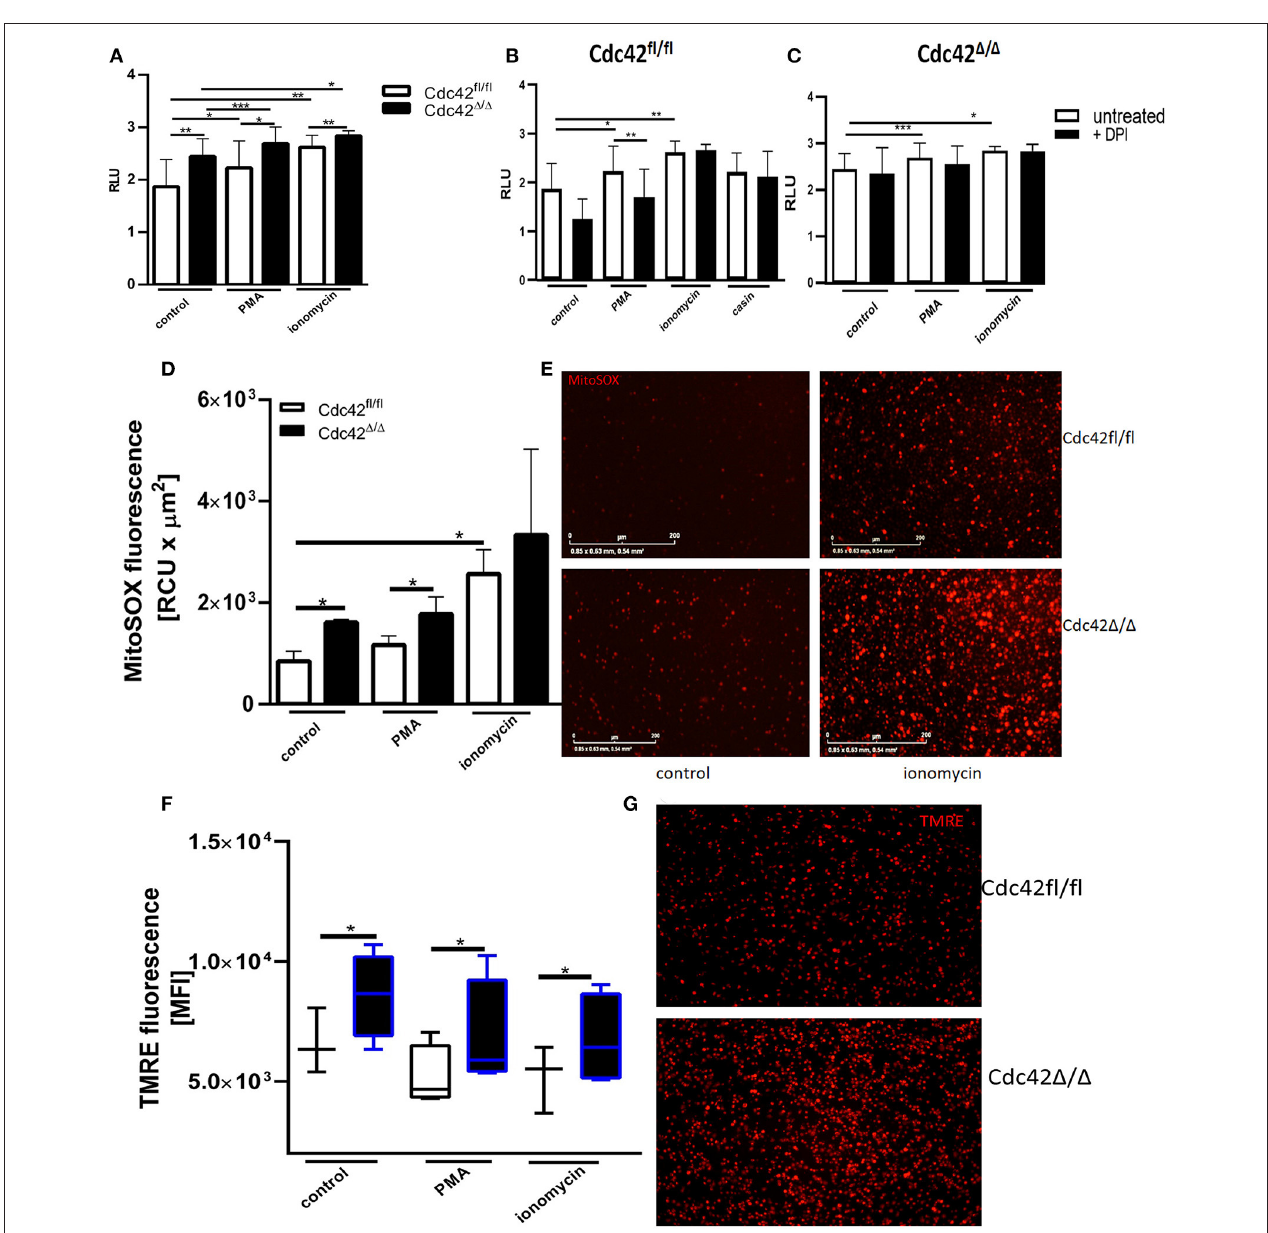
FIGURE 6 | Cdc42 deficient murine neutrophils show increased NET formation in a NADPH oxidase independent manner and display enhanced mitochondrial membrane potential and mitochondrial ROS production. (A) Freshly isolated bone marrow derived murine neutrophils from Cdc42 fl / fl and Cdc42 1/1 mice were left untreated (control) or stimulated with 100nM PMA or 5 µ M ionomycin for 3h at 37 ◦ C. Quantification of NET release by measuring the OD at 450nm of histone-bound DNA, displayed as relative light units (RLU). Data show mean ± SD of 8 independent experiments. *** p ≤ 0.001, ** p ≤ 0.01, and * p ≤ 0.05. (B,C) Freshly isolated bone marrow derived murine neutrophils from Cdc42 fl / fl and Cdc42 1/1 mice were pre-incubated with the NADPH-oxidase inhibitor DPI for 30min at 37 ◦ C. Subsequently, cells were left untreated or stimulated with 100nM PMA, 5 µ M ionomycin or the Cdc42 inhibitor casin (10 µ M, Cdc42 fl / fl only) for 3h at 37 ◦ C. Quantification of NET release by measuring the OD at 450nm of Histone-bound DNA, displayed as relative light units (RLU). Data show mean ± SD of 4 independent experiments. *** p ≤ 0.001, ** p ≤ 0.01, and * p ≤ 0.05. (D,E) Freshly isolated bone marrow derived murine neutrophils from Cdc42 fl / fl and Cdc42 1/1 mice were seeded into a 96-well glass bottom plate. Subsequently, cells were incubated with the mitochondrial ROS indicator mitoSOX for 20min at 37 ◦ C. The formation of mitochondrial ROS of untreated cells (control) or in response to 100nM PMA, or 5 µ M ionomycin was detected for 1h, every 4min at 37 ◦ C using the IncuCyte life imaging. (D) Quantification of mitochondrial ROS by calculating the relative fluorescence of mitoSOX. Data show mean ± SD of 3 independent experiments * p ≤ 0.05. (E) Representative images of the mitoSOX signal of control and ionomycin treated Cdc42 fl / fl and Cdc42 1/1 cells. Freshly isolated bone marrow derived murine neutrophils from Cdc42 fl / fl and Cdc42 1/1 mice were left untreated (control) or stimulated with 100nM PMA or 5 µ M ionomycin. Subsequently, cells were incubated with the mitochondrial membrane potential indicator TMRE for 30min at 37 ◦ C. (F) Mitochondrial membrane potential in response to different stimuli assessed by using flow cytometry. Data show mean ± SD of 5 independent experiments * p ≤ 0.05. (G) Representative images showing the TMRE signal of untreated Cdc42 fl / fl and Cdc42 1/1 cells.